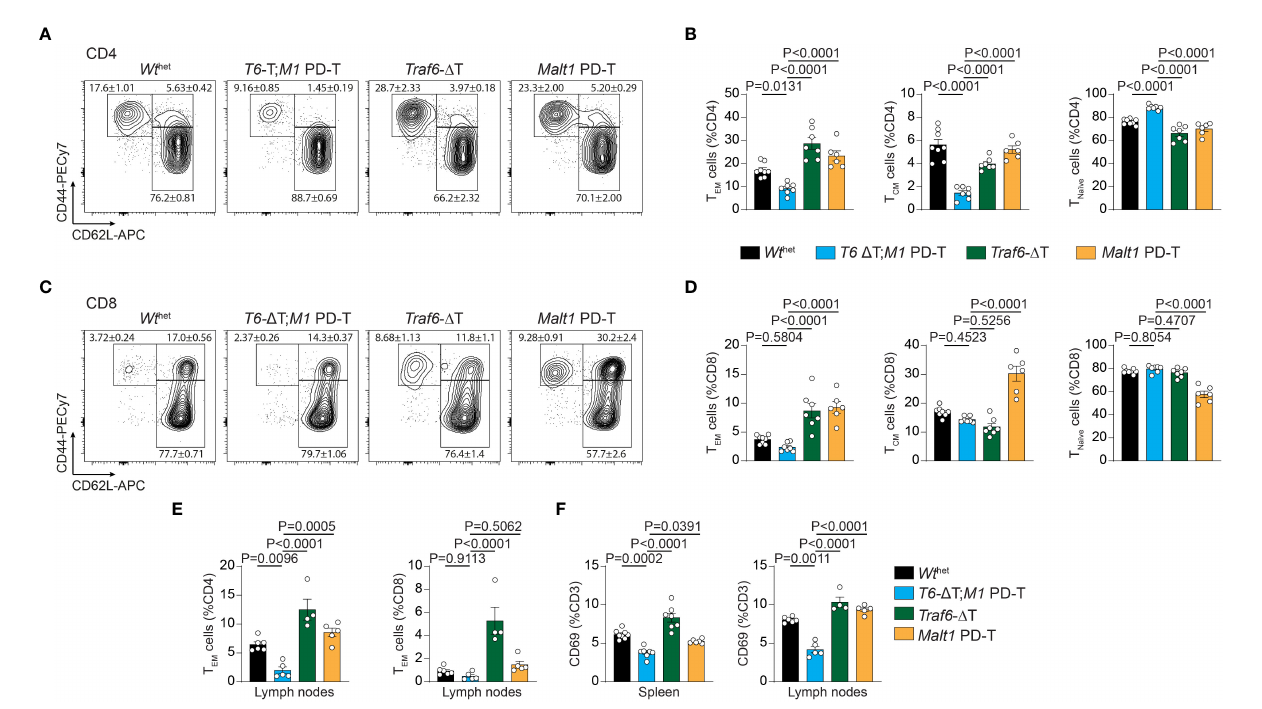
FIGURE 2 Effects of single or combined TRAF6 KO and MALT1 paracaspase mutation on T cell activation. (A – D) Flow cytometric analysis of CD44 and CD62L expression on CD4 + (A, B) and CD8 + (C, D) T cells with relative numbers of T EM (CD44hi CD62Llo), T CM (CD44hi CD62Lhi) and T naïve (CD44lo CD62Lhi) cells in spleen of Wt het , T6- D T; M1 PD-T, Traf6 - D T and Malt1 PD-T mice. (E) Flow cytometric analyses of CD4 + and CD8 + CD44hi CD62Llo T EM cells from lymph nodes of mice as depicted in (A) . (F) Relative numbers of CD3 + CD69 + T lymphocytes in spleen and lymph nodes of mice as depicted in (A) . Bars show the means ± SEM, and P values were calculated by one-way ANOVA with Tukey ’ s multiple comparison test. All analyses were performed with mice 9-11 weeks of age. Each dot represents one